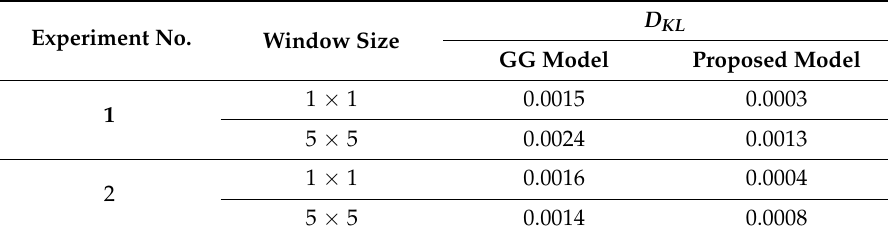
Table 2. Comparison of fitting